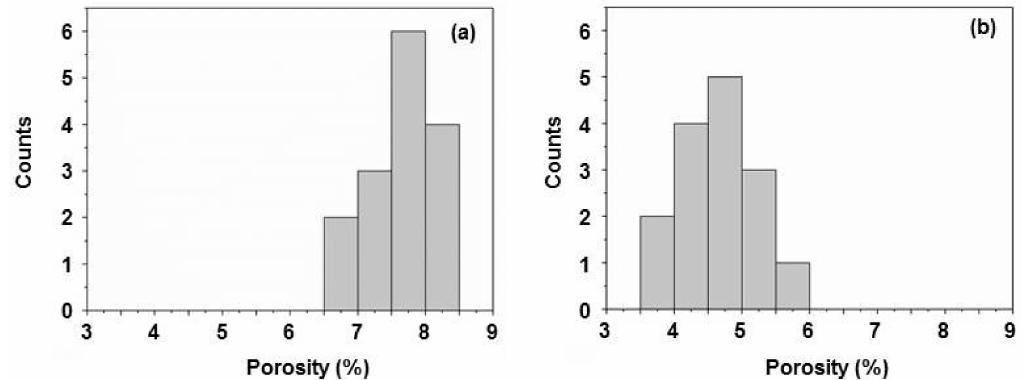
Figure 7. Distribution of the porosity of the SSM ( a ) after concentration gradient-driven nanodisc insertion (evaluation for four different sample areas) and ( b ) after electrophoresis-based insertion (evaluated for five different sample